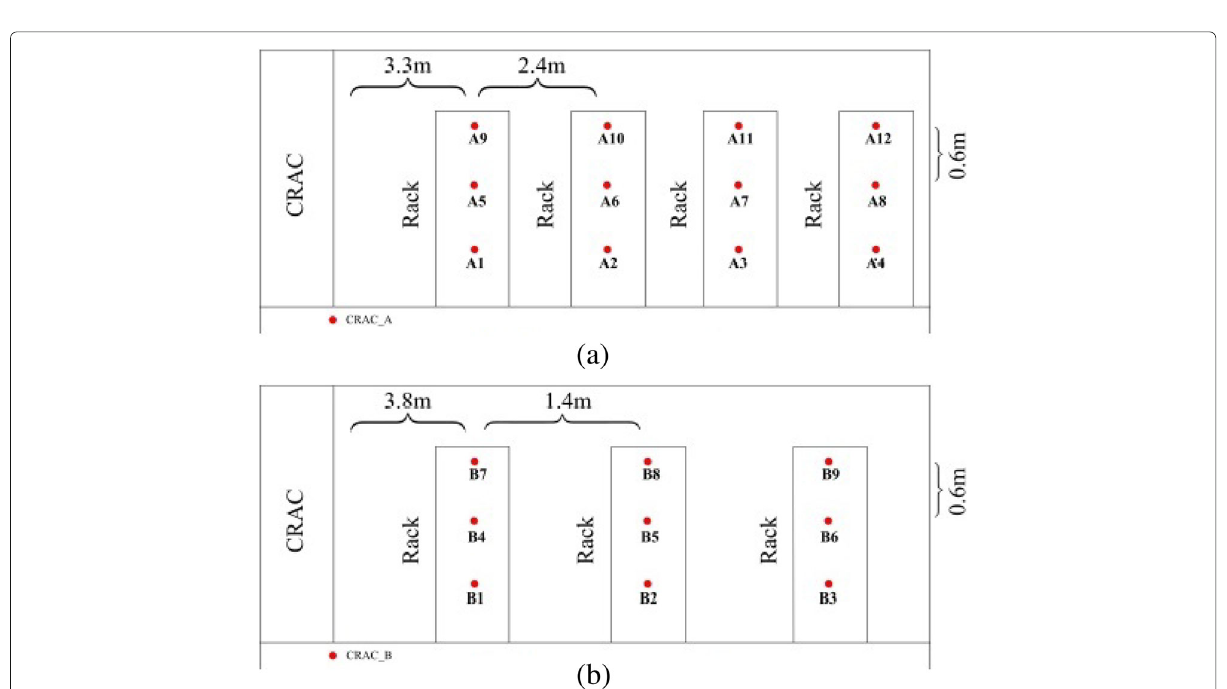
Fig. 4 Layout of sensors deployment. a Computer room 1. This computer room is dedicated to servers. The horizontal distance between the first rack and CRAC is 3.3 m. The inter-rack distance is 2.4 m. b Computer room 2. This is a small computer room dedicated to network devices. The horizontal distance between the first rack and CRAC is 3.8 m. The inter-rack distance is 1.4